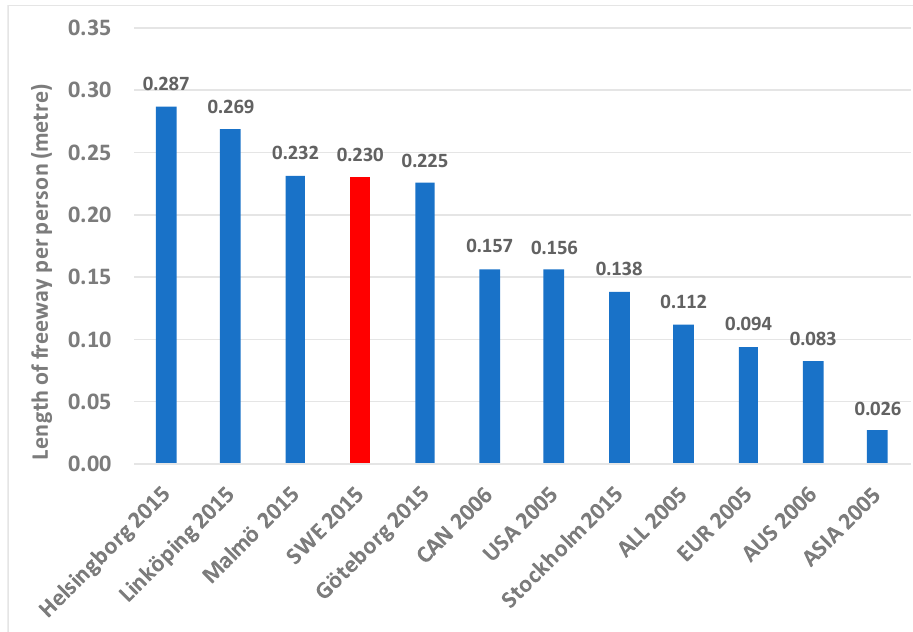
Figure 4. Freeway linear length per person in five Swedish cities (2015) compared to a sample of global cities (2005–2006).